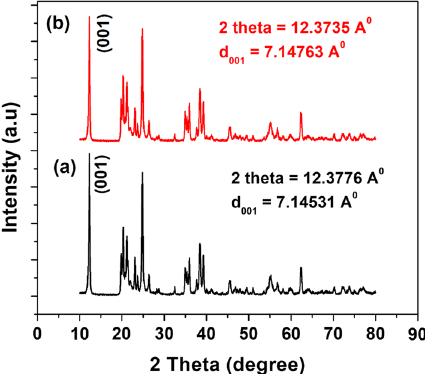
Fig. 4 Powder XRD diffractogram of a pure kaolin and b CTAB–